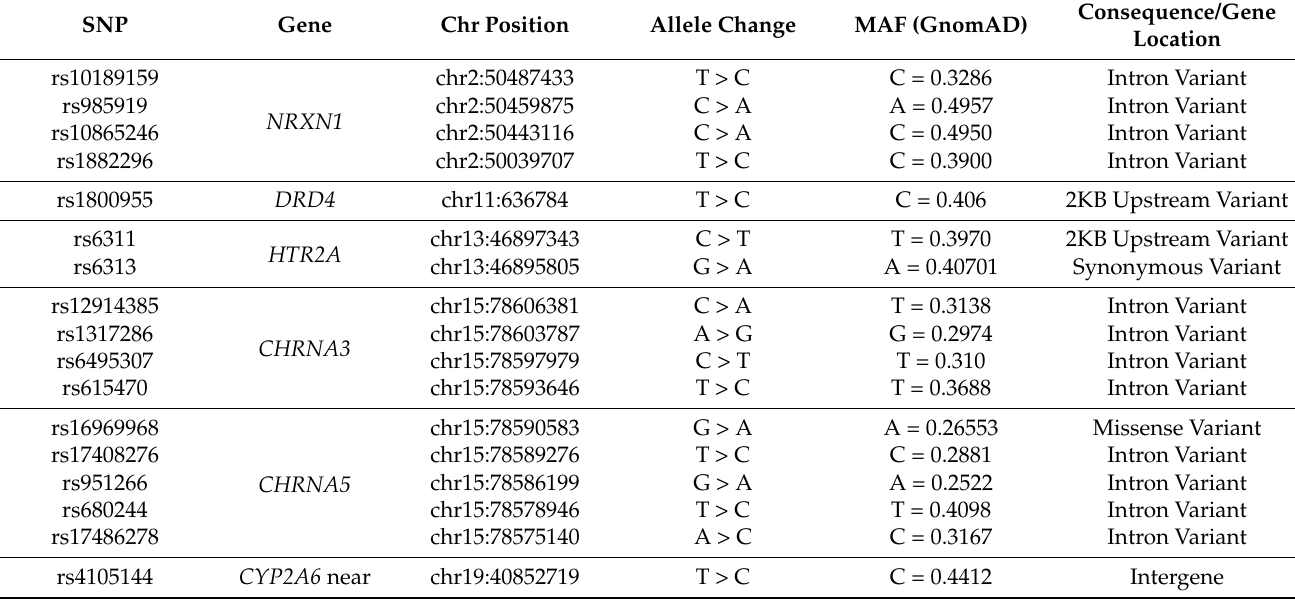
Table 2. Characteristics of polymorphisms previously reported on the fine mapping of six genomic